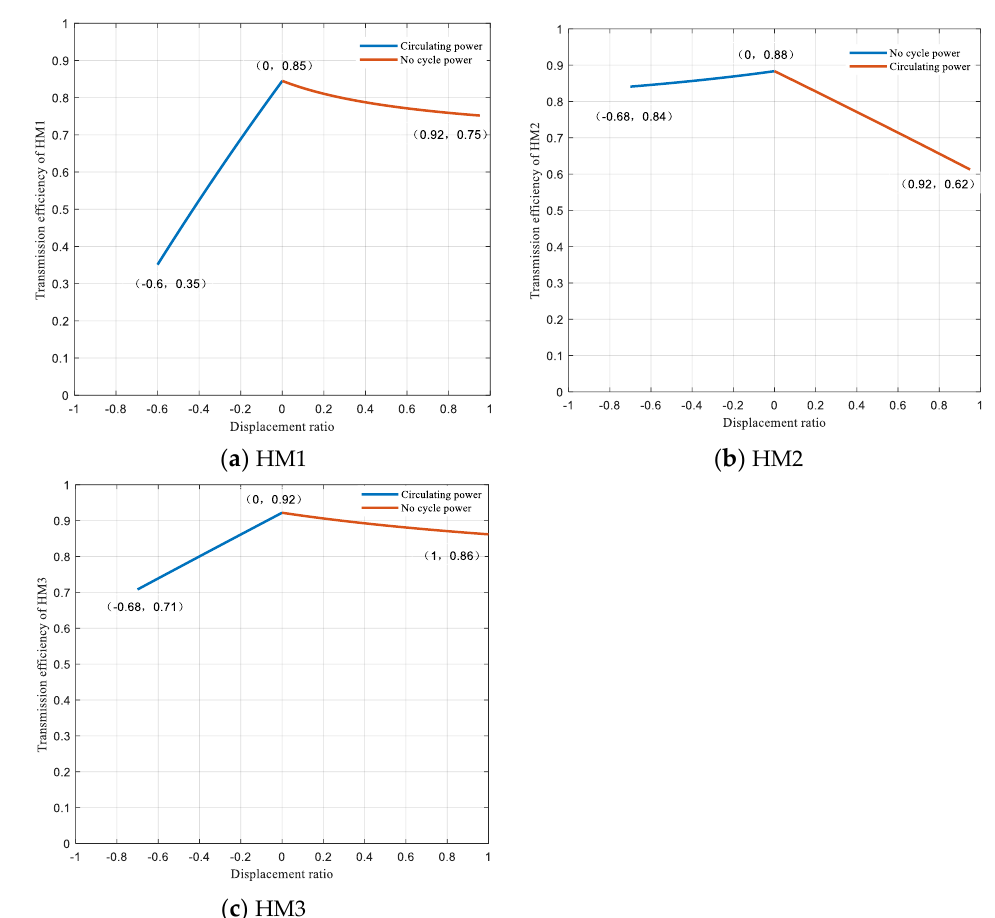
Figure 12. HMCVT transmission efficiency characteristic diagram.